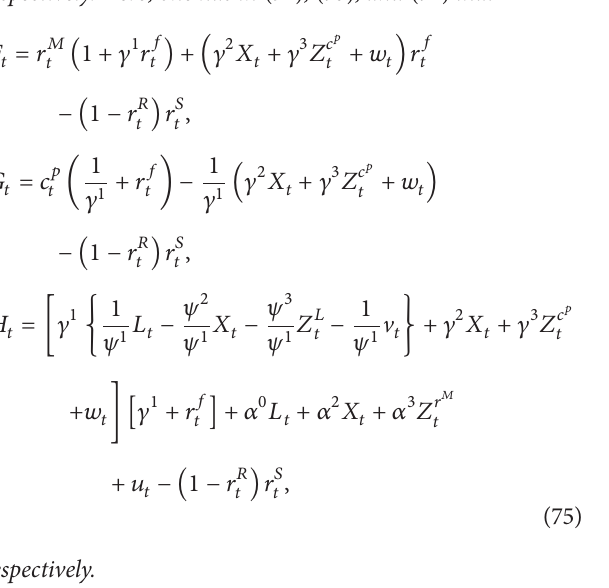
Table 2: Asset securitization parameter